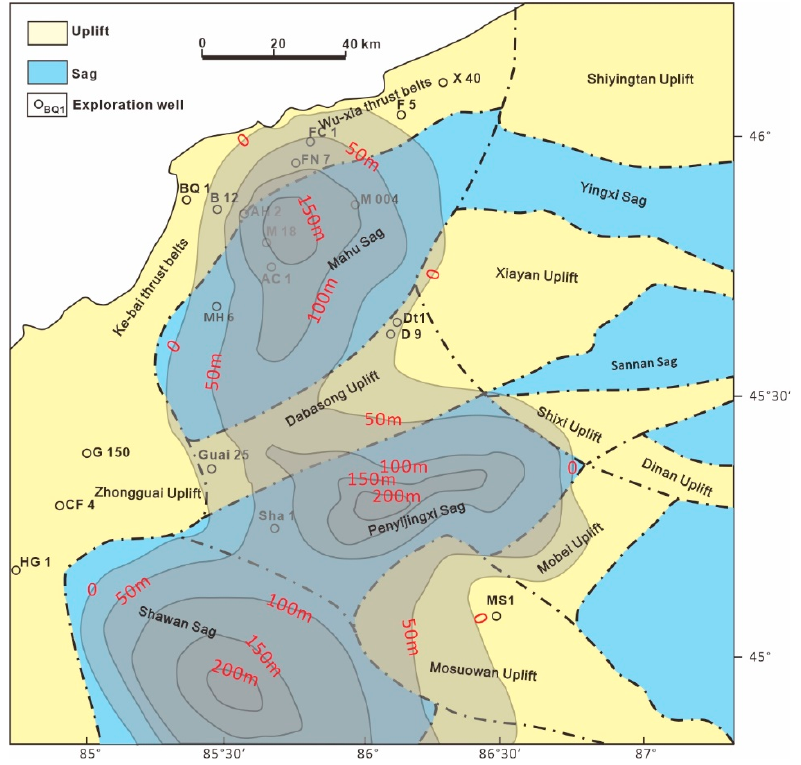
Figure 5. Source rock thickness isoline map of the Permian Fengcheng Formation in the Junggar Basin.